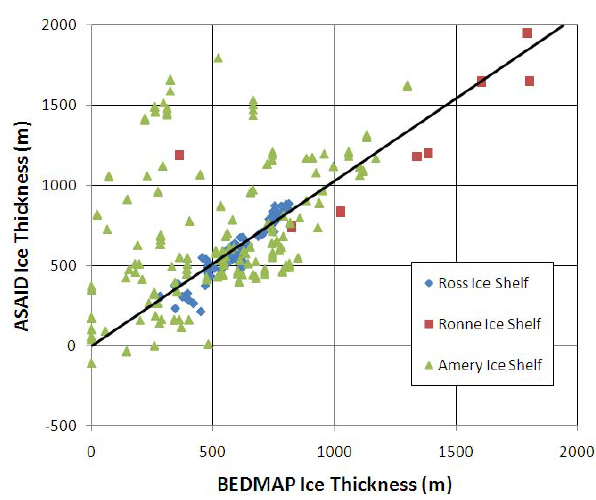
Fig. 12. Actual measured ice thickness at common points along the ASAID grounded ice boundary extracted from BEDMAP mission data versus actual ice thickness calculated from ASAID preferred surface elevations. Data symbols distinguish the three ice shelf regions. Sloped line is a linear fit through all points constrained to pass through (0,0) (cf. Table 5).